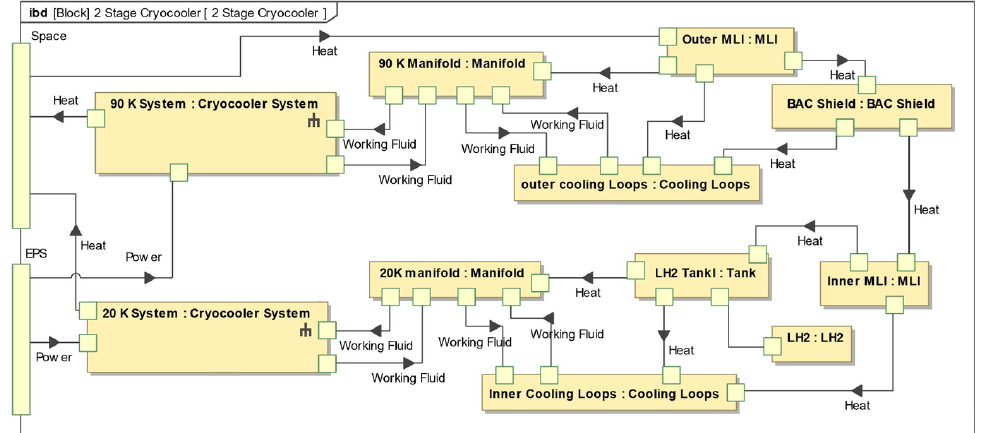
Figure 15. Two circuit cooling thermal management system